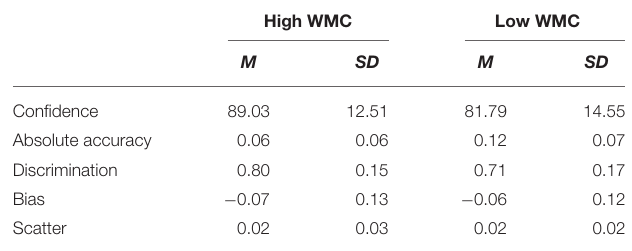
TABLE 3 | Mean word recall accuracy for correct and incorrect true/false decisions for high and low WMC participants.